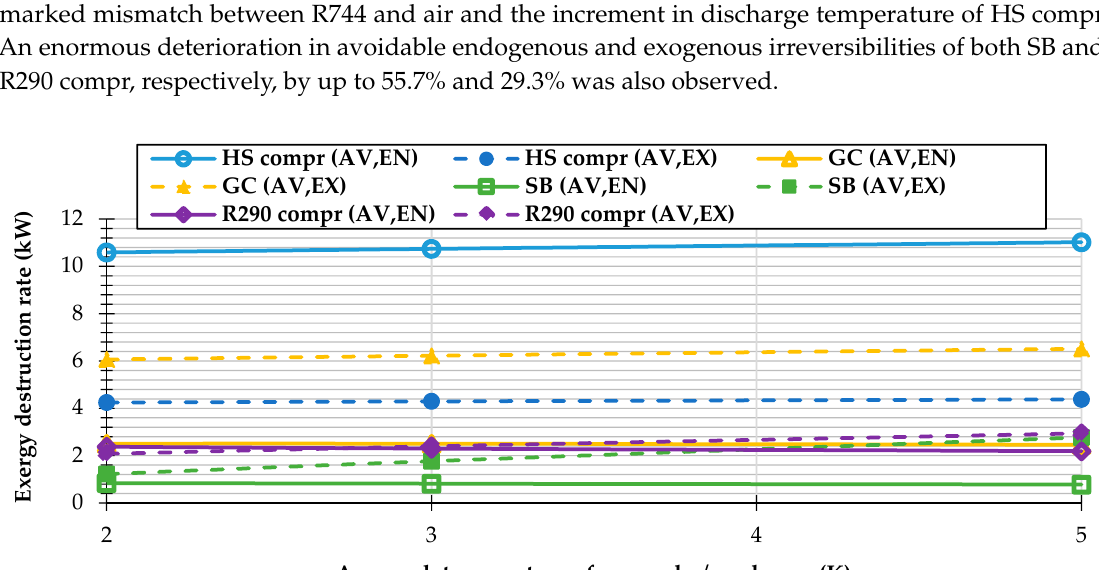
Figure 9. Effect of the gas cooler/condenser approach temperature on the avoidable endogenous and exogenous exergy destruction rates of some selected components belonging to the investigated system at the outdoor temperature of 40 °C.